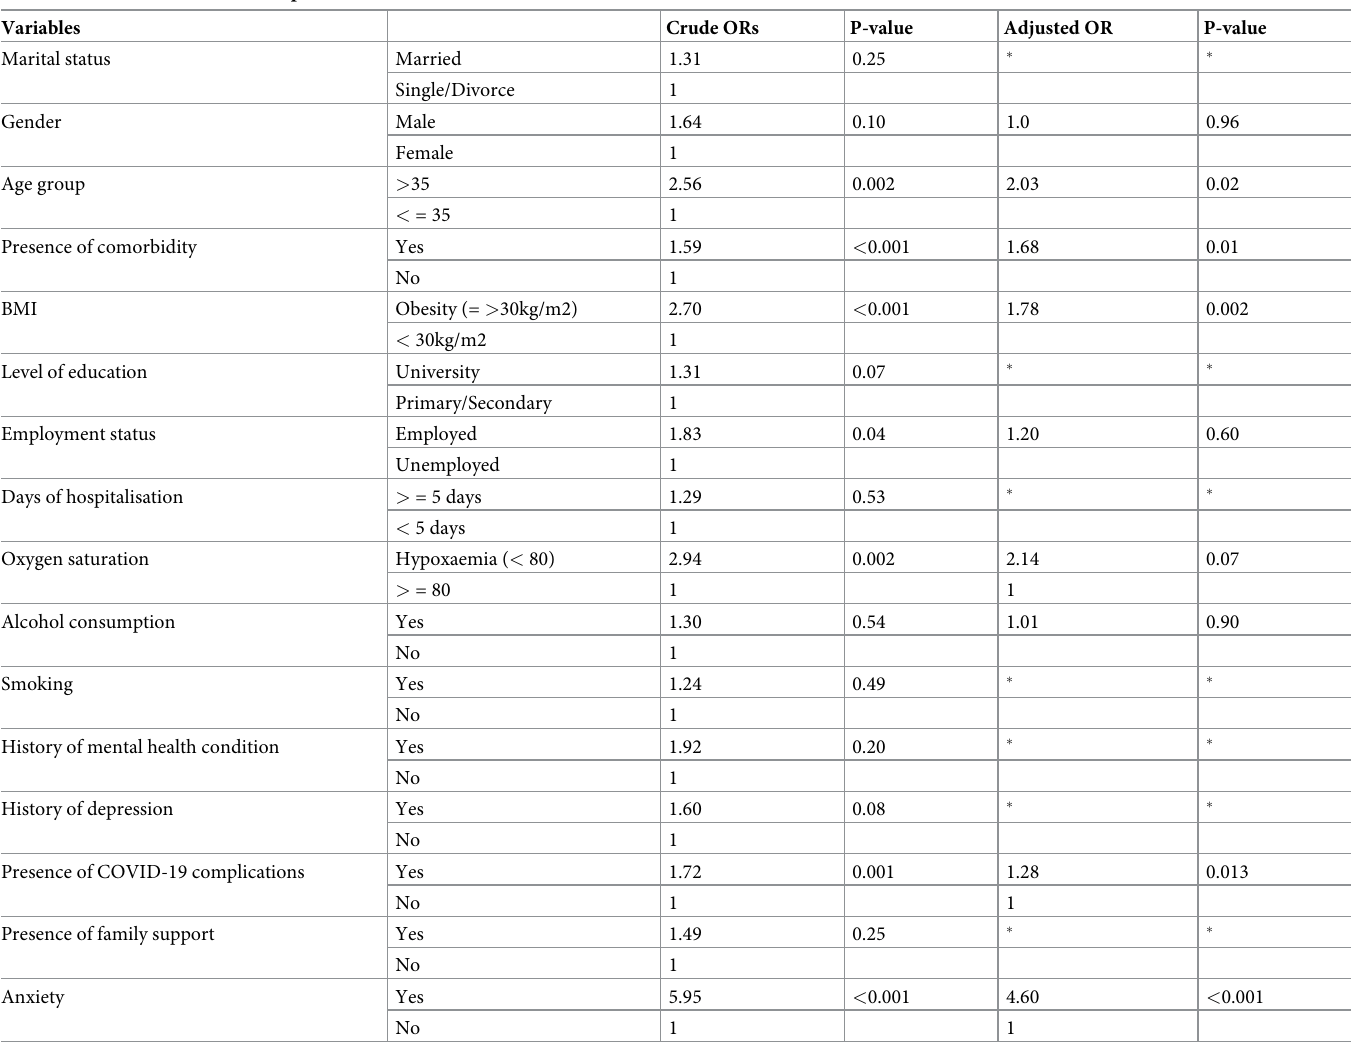
Table 2. Factors associated with